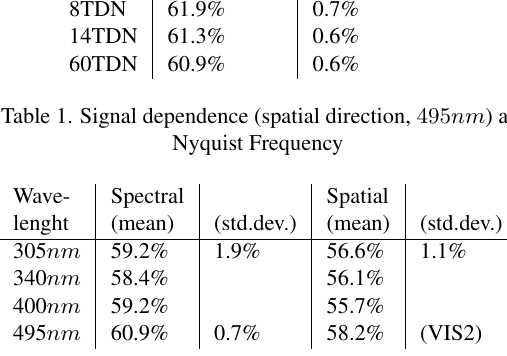
Table 2. Spectral and spatial MTF dependence at Nyquist